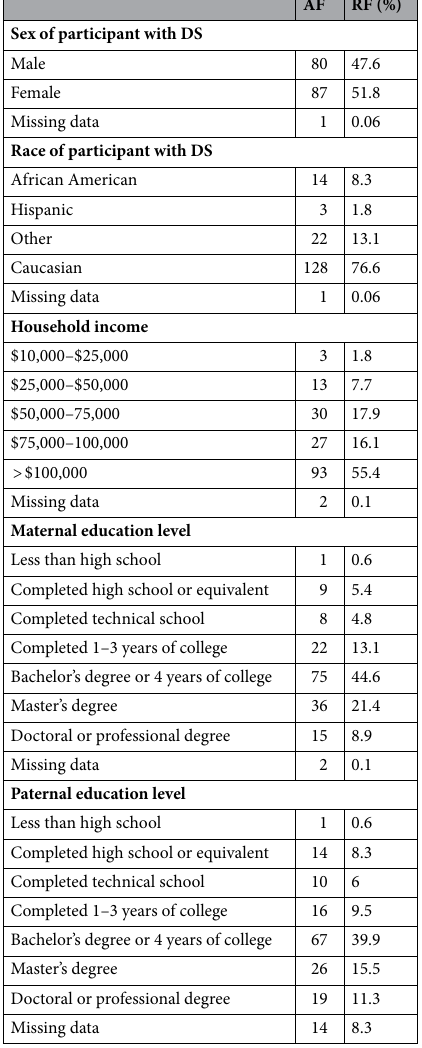
Table 1. Descriptive analysis of the sociodemographic parameters of the 168 participants with DS and their families. First column shows values for absolute frequencies, and second column shows values for relative frequencies. DS Down syndrome, AF absolute frequency, RF relative